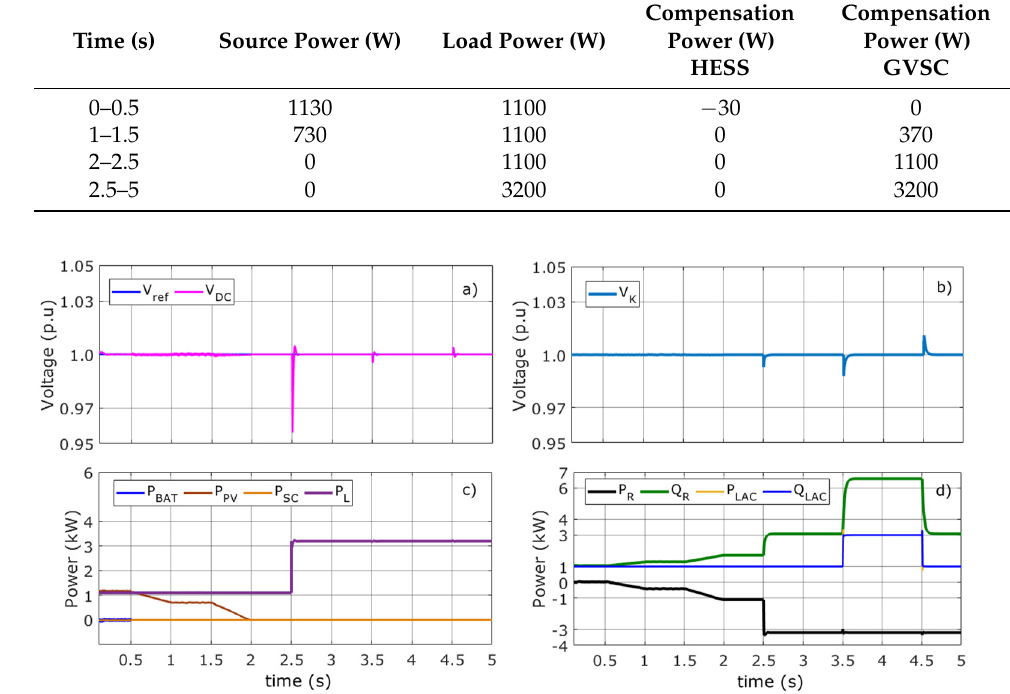
Figure 8. Voltage and power flow in Mode 3. ( a ) Reference and DC bus voltage ( b ) AC voltage ( c ) Battery, photovoltaic, SC, and load powers ( d ) Active and reactive VSC powers, active and reactive load powers.